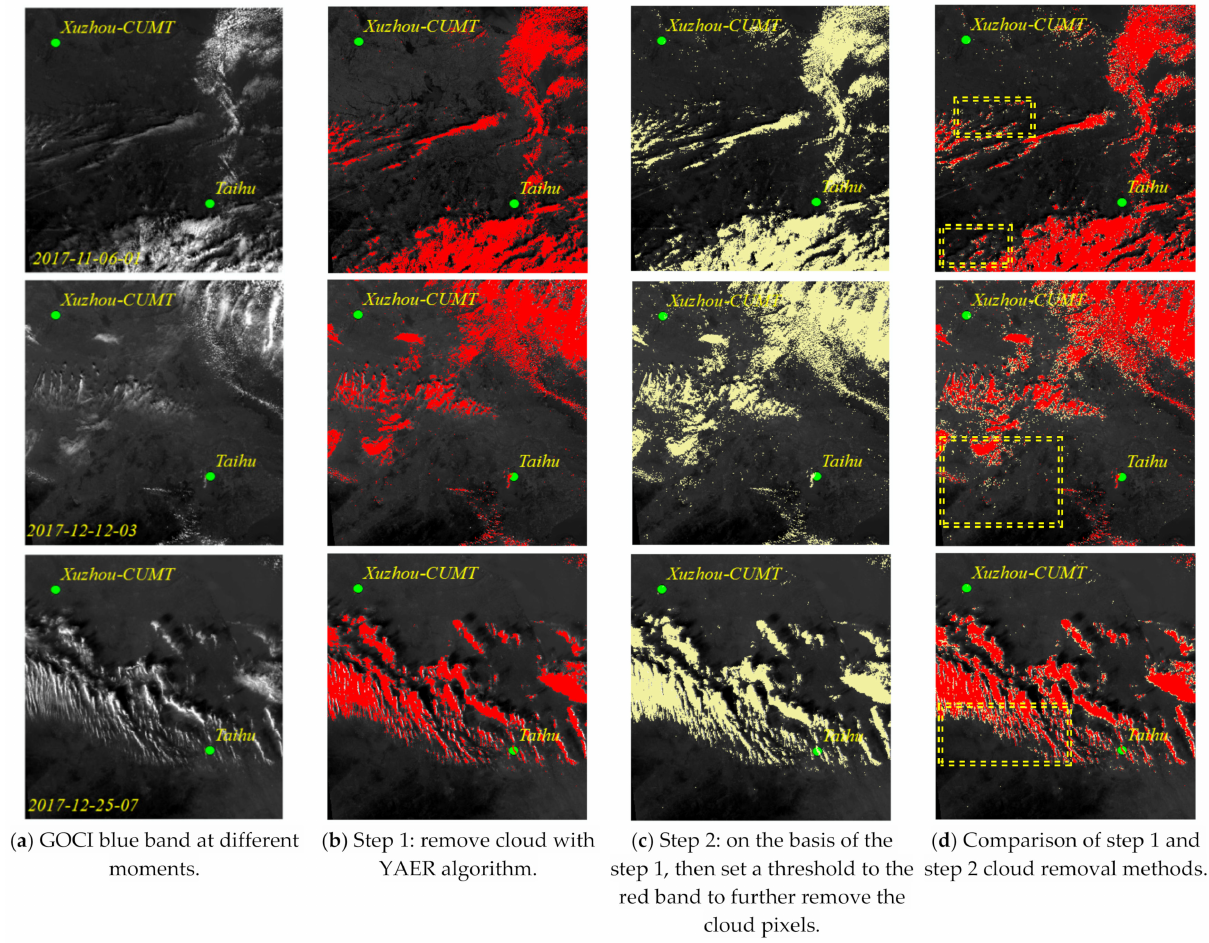
Figure 12. Cloud removal results of GOCI